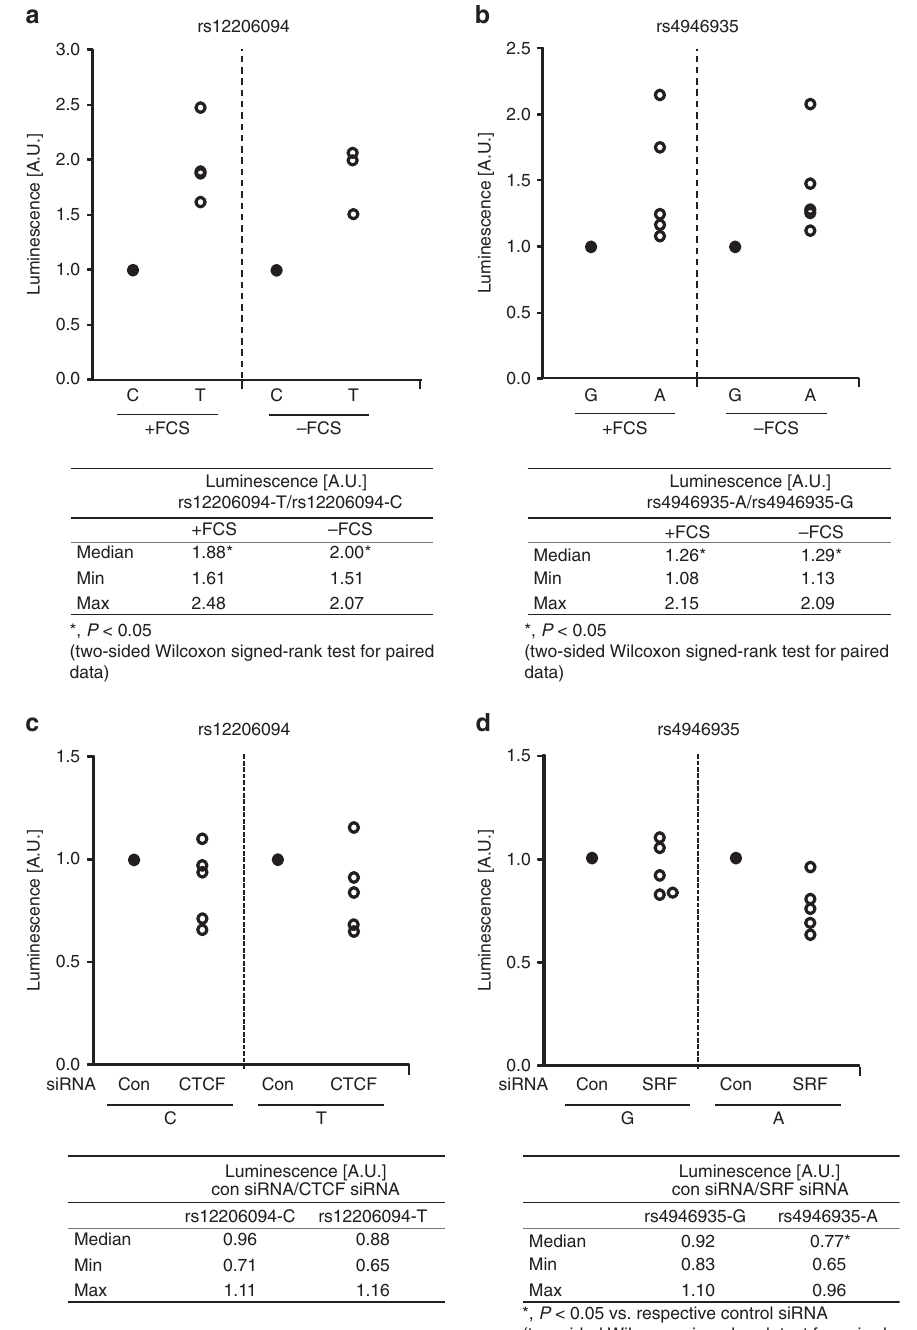
Fig. 3 FOXO3 SNVs rs12206094 and rs4946935 in fl uence luciferase promoter activity, and knockdown of SRF links this transcription factor to rs4946935. a , b Luciferase promoter assays were perfomed in Panc1 cells transfected with allele-speci fi c constructs for rs12206094 ( a ) and rs4946935 ( b ) in both the presence and absence of FCS. For both SNVs, the promoter activity in cells transfected with constructs containing the respective major allele was set = 1 (black dot). Each white dot represents one independent experiment ( n = 5). The tables below the fi gures show the median as well as the minimum and maximum values for the ratio of the longevity allele to the respective alternative allele, taking into account all experiments. c , d Knockdown of transcription factors was done using speci fi c siRNAs. The luciferase activity in cells treated with control siRNA (con siRNA) instead of the transcription factorspeci fi c siRNA was set = 1 (black dot) for each allele of each SNV. Each white dot represents one independent experiment ( n = 5). The tables below the fi gures show the median as well as the minimum and maximum values for the ratios of the activity in presence of con siRNA and transcription factor-speci fi c siRNA for each allele, taking into account all experiments. a – d For determination of speci fi c luciferase activity, activity of the fi re fl y luciferase was normalized to the activity of the renilla luciferase. P ≤ 0.05 was considered statistically signi fi cant (two-sided Wilcoxon signed-rank test for paired